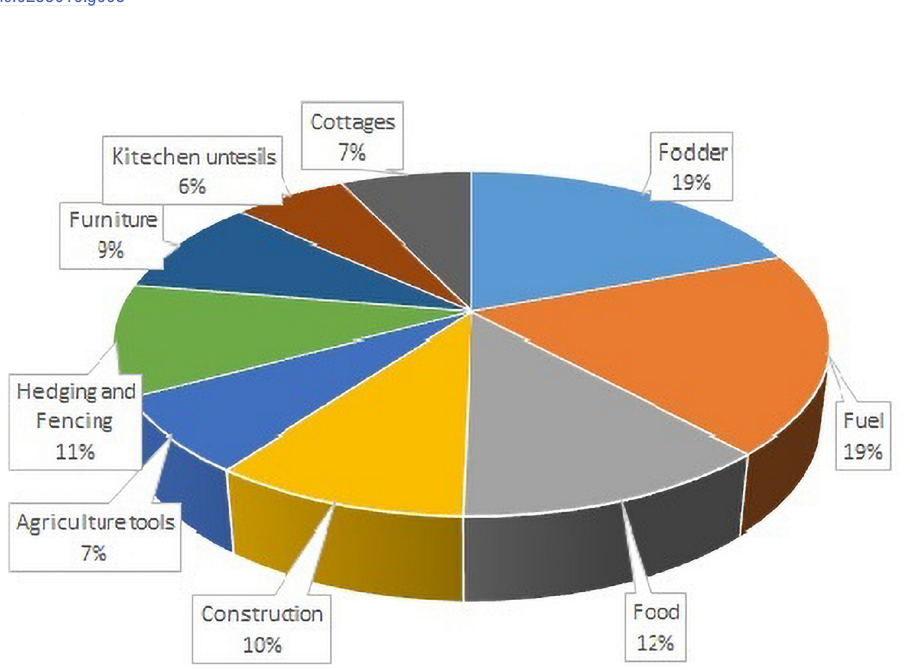
Fig 9. Different ethnobotanical uses of plants used by local people in different categories in study area of Dawarian and Rati Gali of District Neelam of Azad Jammu and Kashmir.